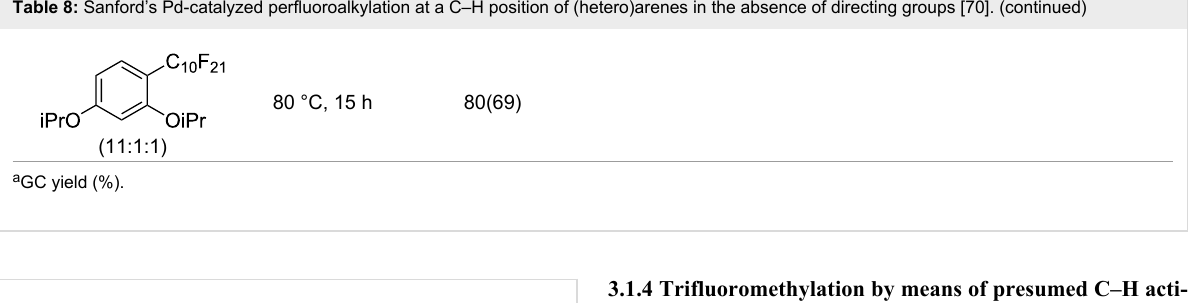
Table 8: Sanford’s Pd-catalyzed perfluoroalkylation at a C–H position of (hetero)arenes in the absence of directing groups [70]. (continued)